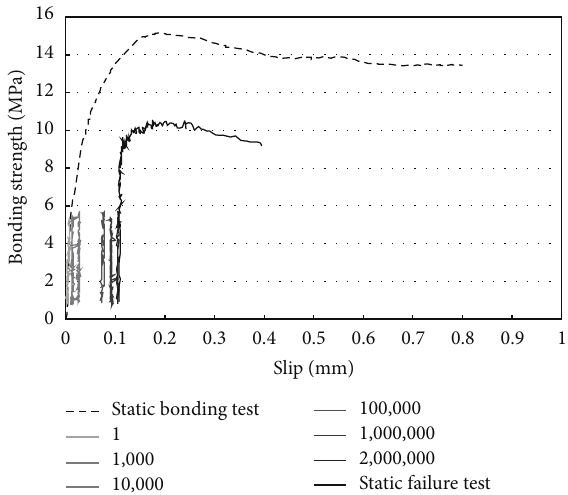
Figure 9: Bond stress-slip relationship of the 5𝑑 𝑏 specimen under 70% stress level of the ultimate strength.